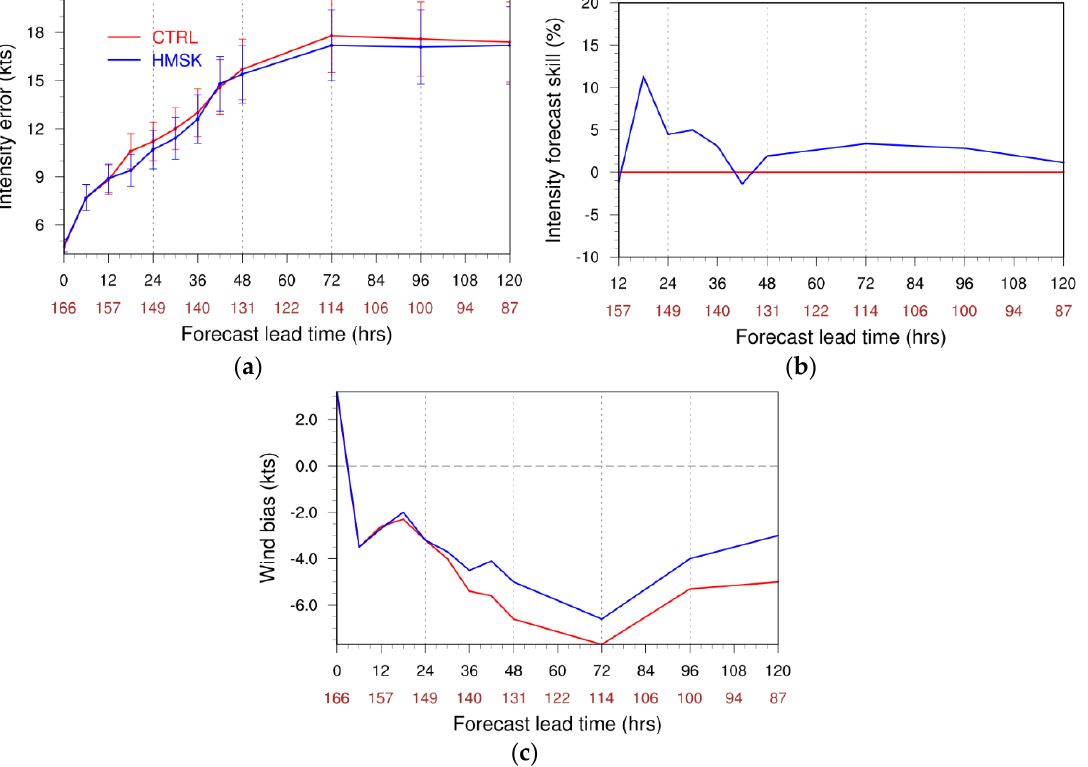
Figure 10. Performance comparison of intensity forecasts between CTRL (red) and HMSK (blue) from four selected Atlantic hurricanes in 2017–2018. ( a ) Intensity forecast error, ( b ) intensity forecast skill relative to CTRL, and ( c ) intensity forecast bias.